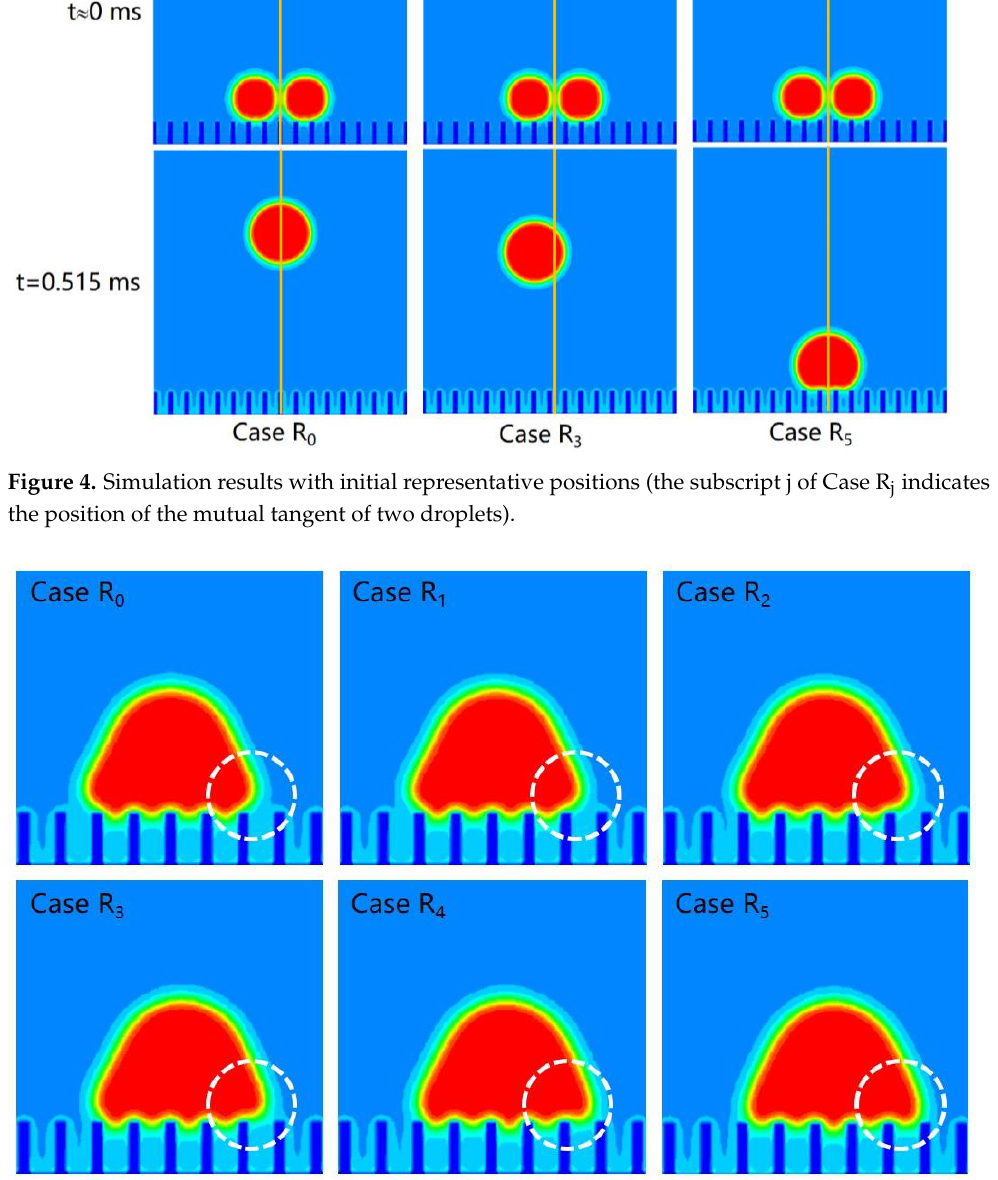
Figure 5. Merged droplet of Case R j (j = 0, 1, 2, 3, 4, 5) at t = 0.0258 ms. The merged droplet in Case R 0 ~R 3 covers 5 micropillars of the surface while in Case R 4 and R 5 covers